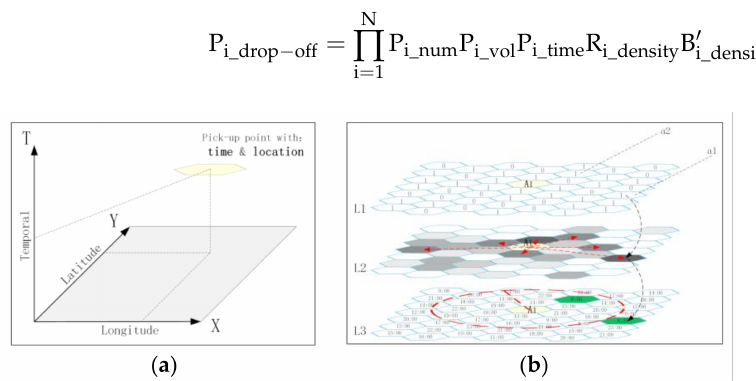
Figure 8. ( a ) Schematic diagram of the grid where the pickup point location. ( b ) Schematic diagram of three-layer framework. L1: the net inflow ratio. L2: the maximum possible visit distance of the grid i. L3: the probability of visit in a specific period of the